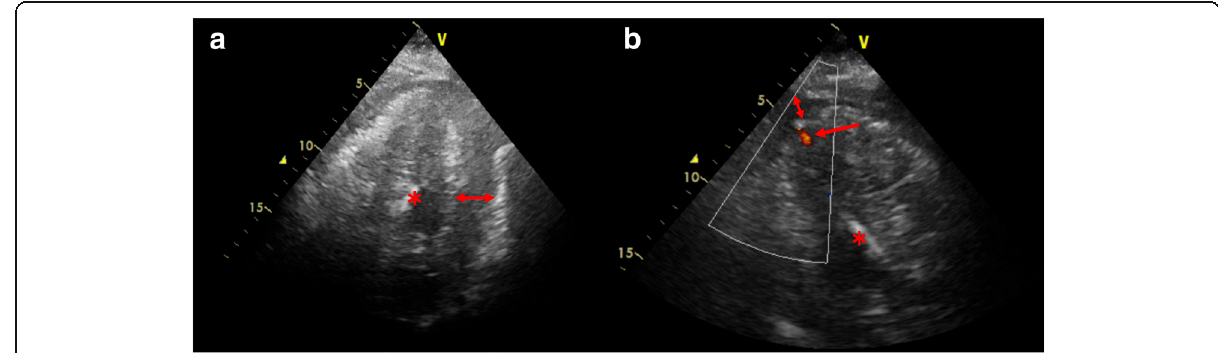
Fig. 1 Apical four chamber view ( a ) and apical long-axis view ( b ) by transthoracic echocardiography. Note the pericardial effusion (double arrow) and the abnormal flow on apex of the left ventricle (small arrow), part of the IMPELLA® (asterisk). The tip of the IMPELLA® is not